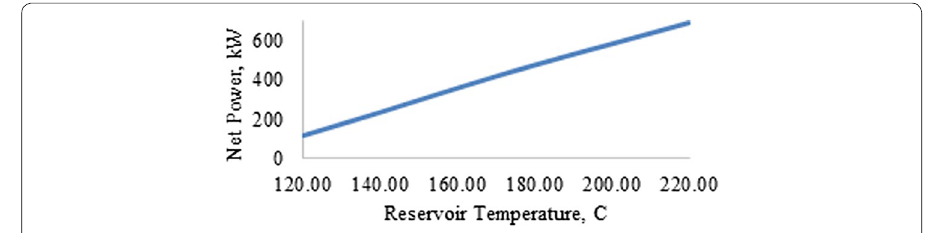
Fig. 19 Net power increase with reservoir